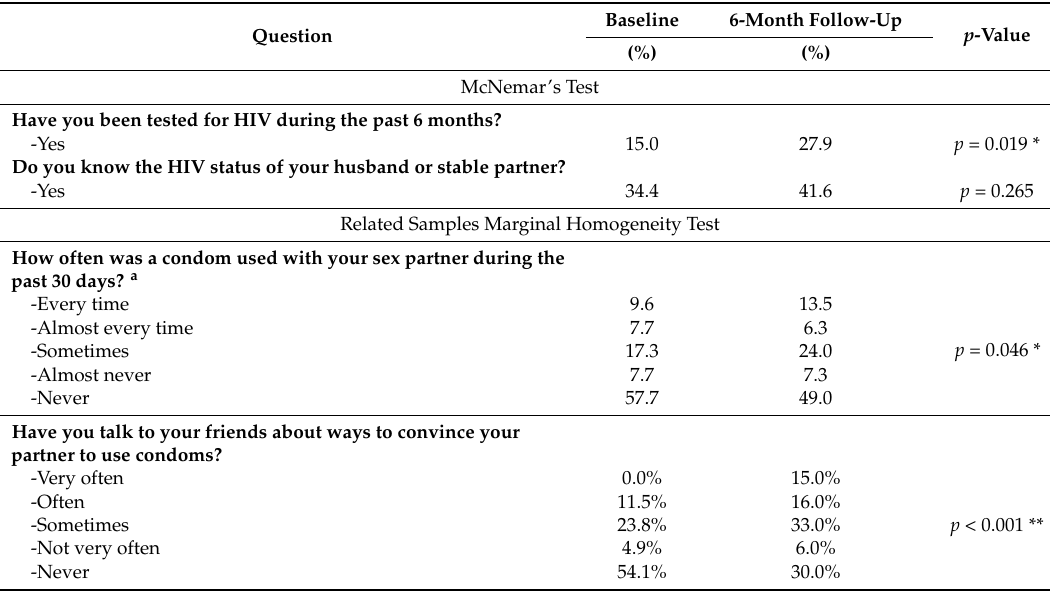
Table 3. Results of McNemar’s Test and Related Samples Marginal Homogeneity Test of Changes in Condom Use, HIV Testing, and HIV Related Communications with Friends from Baseline to 6-Month